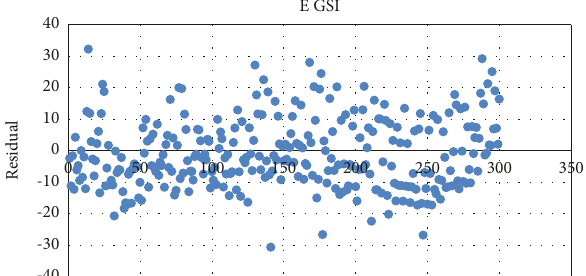
Figure 12: The graphic representation of GSI error computed with (1) and filed measurement of Roudbar geological